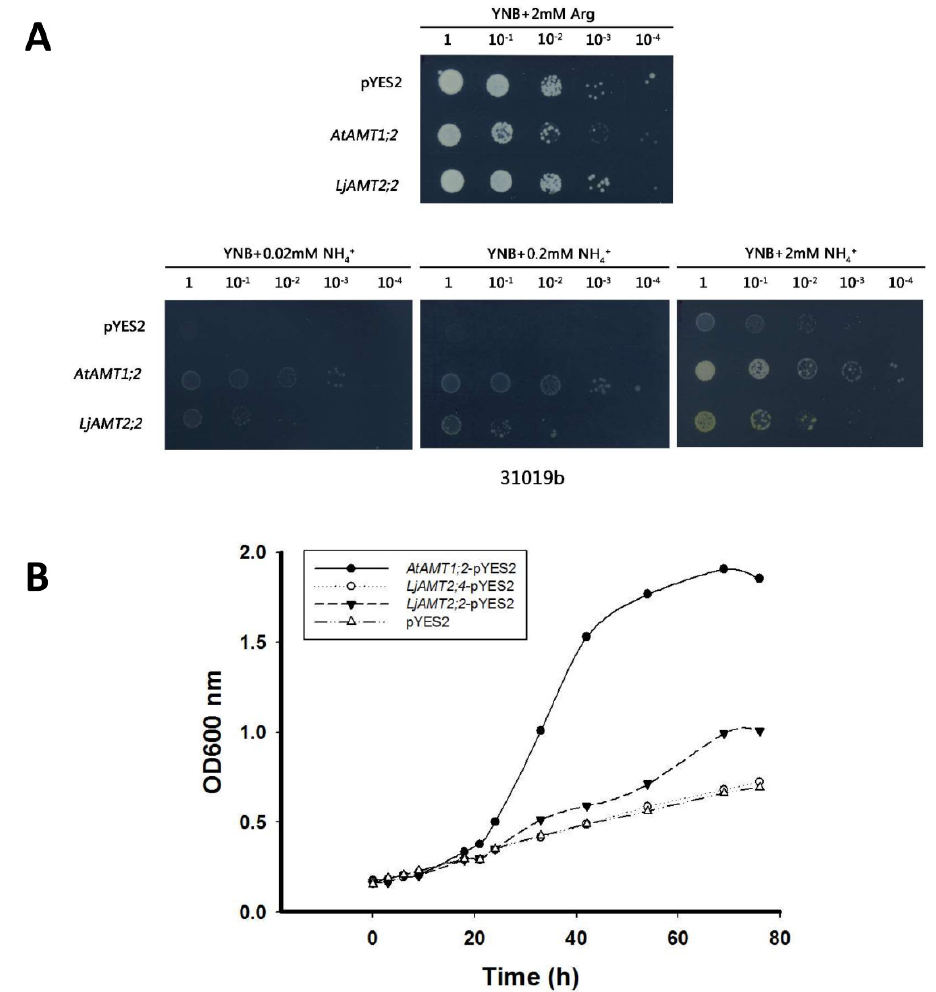
Figure 3. Functional analysis of LjAMT2;2 in ammonium-deficient yeast. ( A ) Ammonium-deficient yeast supplementation experiment. ( B ) Yeast growth curves.